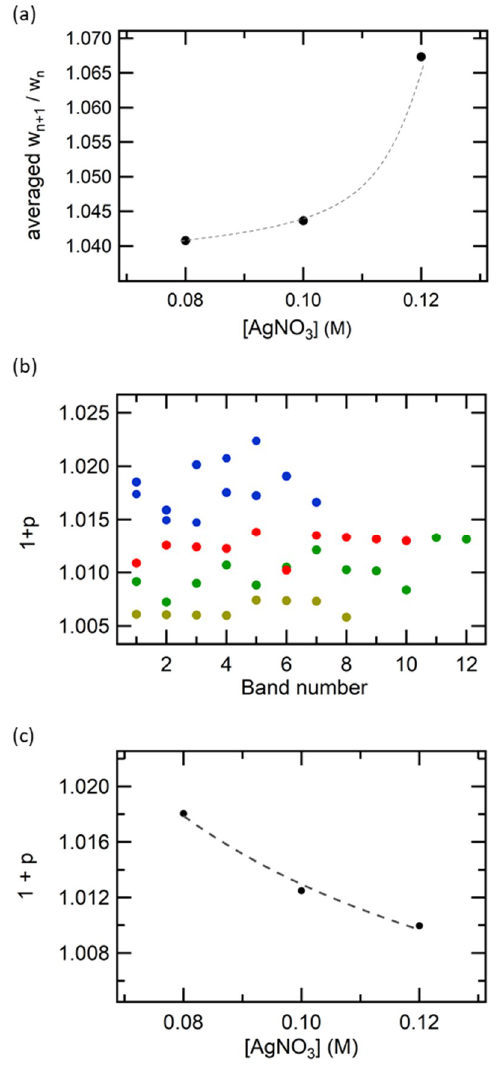
Figure 4. ( a ) Averaged w n+ 1 / w n as the function of [AgNO 3 ]. ( b ) Variation in (1 + p ) as the function of the band number. Blue: [NaCl] = 0.01 M, [AgNO 3 ] = 0.08 M; red: [NaCl] = 0.01 M, [AgNO 3 ] = 0.10 M; green: [NaCl] = 0.01 M, [AgNO 3 ] = 0.12 M; and brown: [NaCl] = 0.015 M, [AgNO 3 ] = 0.20 M. ( c ) Variation in (1 + p ) as the function of [AgNO 3 ], where the dashed line depicts the best-fit to the Matalon–Packter law (Equation (2)).